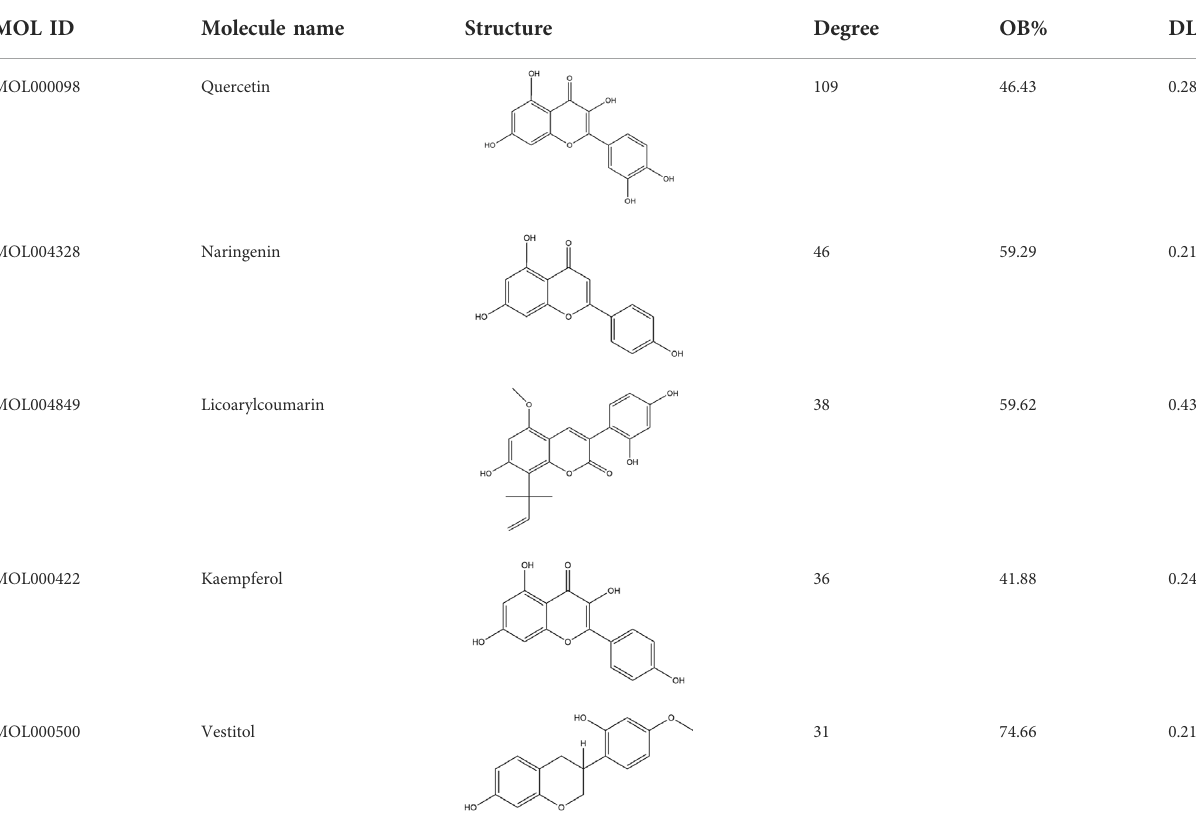
TABLE 2 2D structure of top 5 active components screened by degree